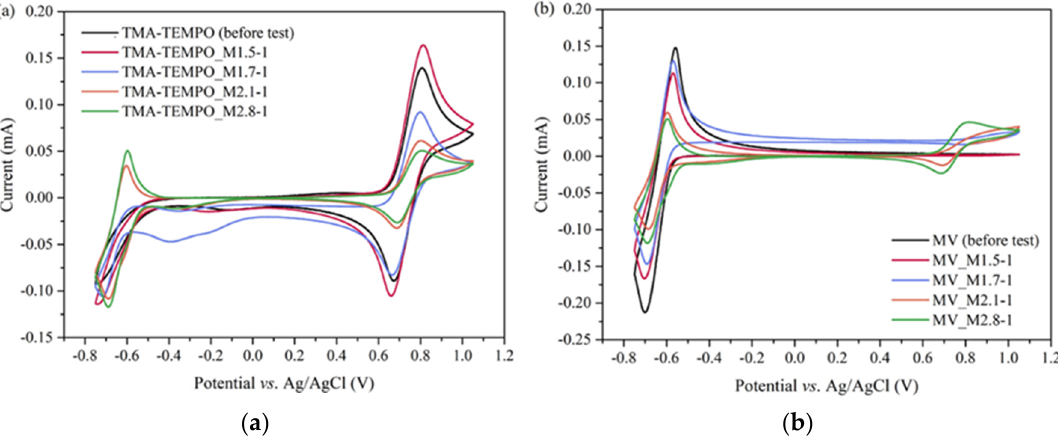
Figure 4. Cyclic voltammograms of TMA-TEMPO and MV solutions for each membrane before and after the cell cycling tests: ( a ) TMA-TEMPO half-cell and ( b ) MV half-cell. Scan rate: 200 mV·s −1 .